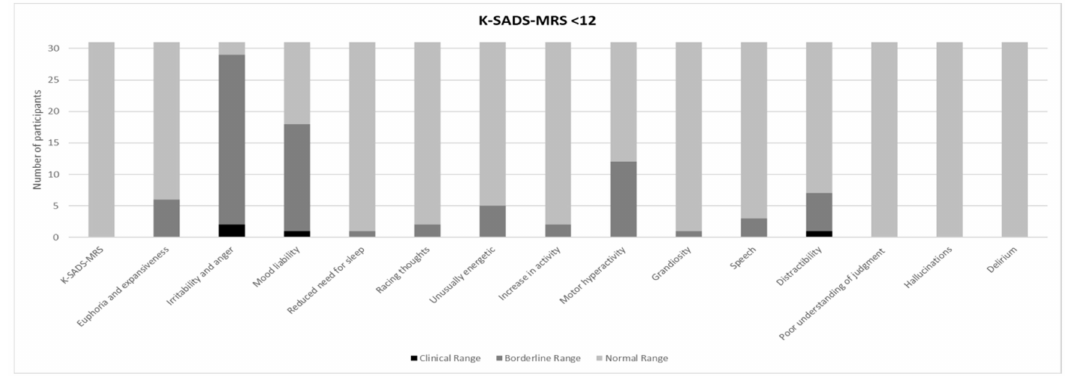
Figure 4. Prevalence of manic symptoms in K-SADS-MRS < 12 (K-SADS-MRS-). Nineteen individuals (51%) obtained a normal score (CDRS-R − < 55; a total score of M ± SD: 47.5 ± 6.9). Despite this, the subscales “Irritability” and “Low